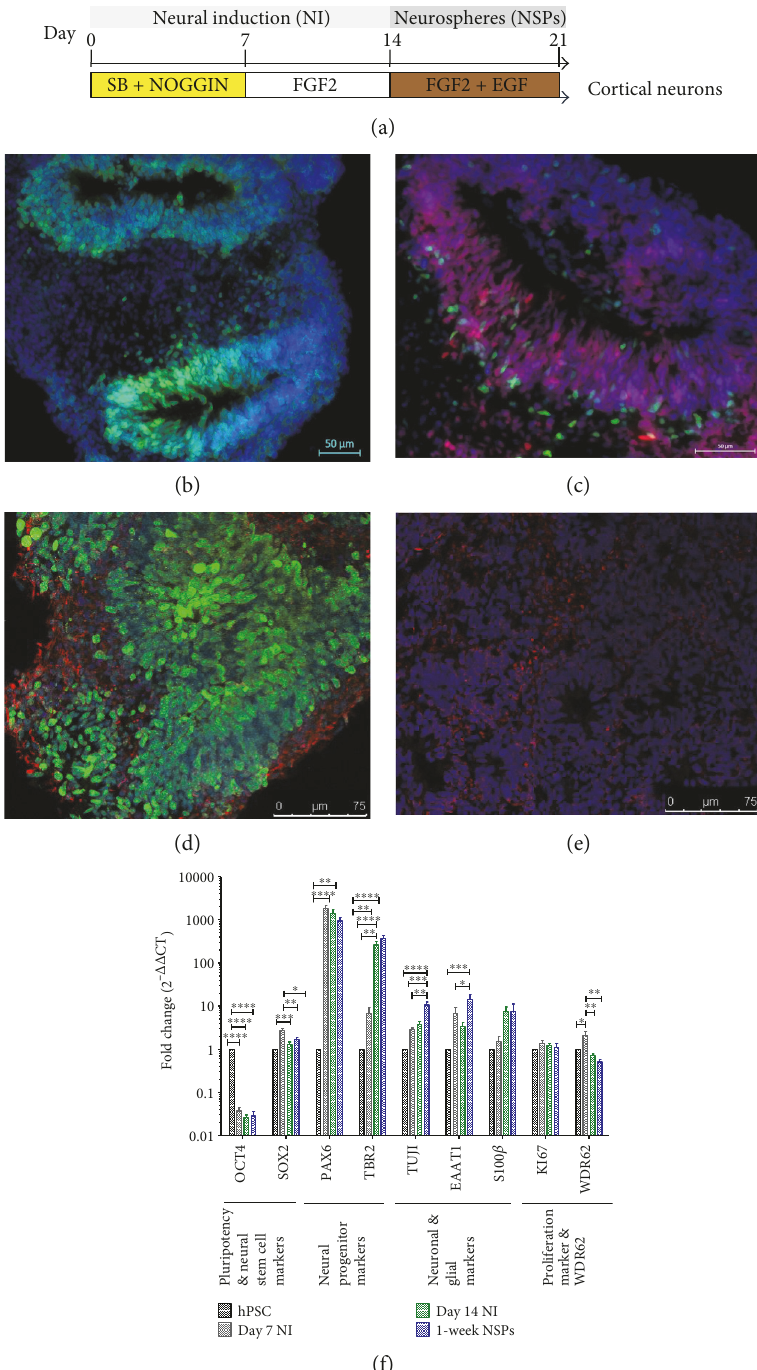
Figure 1: Expression of WDR62 in hPSC-derived neural progenitors. (a) Schematic diagram outlining neural induction protocol for deriving cortical neuronal progenitors. (b-c) DS neural induction protocol generates neural progenitors expressing early neural progenitor markers SOX2 (b, green) and PAX6 (c, red) and intermediate progenitor marker TBR2 (c, green). DAPI stains of nuclei are also shown. Scale bars =50 μ m. (d-e) hPSC-derived 1-week-old NSPs also express neuronal marker TUJ1 (d, red), proliferative marker KI67 (d, green), and glial marker S100 β (e, red). DAPI stains of nuclei are shown in (e). Scale bars =75 μ m. (f) Gene expression analyses of pluripotency marker OCT4; neural progenitor markers SOX2, PAX6, and TBR2; neuronal marker TUJ; glial markers EAAT1 and S100 β ; and proliferative marker KI67 and WDR62 across several time points of the neural induction protocol, including hPSC, day 7 NI, day 14 NI, and 1-week NSPs ( n ≥ 4 independent experiments for each time point, > 3 NSPs per experiment). Data presented as means ± S.E.M. one- way ANOVA with a post hoc Bonferroni multiple comparison was used to assess signi fi cance for each gene, comparing all pairs of time points. ∗ P < 0 05 ; ∗∗ P < 5 0 E − 03 ; ∗∗∗ P < 1 0 E − 04 ; ∗∗∗∗ P < 1 0 E − 05 . NI: neural induction; NSPs: